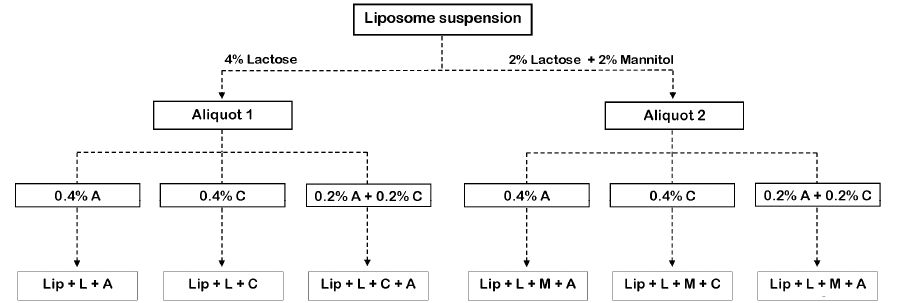
Figure 1. Liposome mixtures assayed for palatability. (A: sodium alginate; C: carboxymethylcellulose; L: lactose; M: